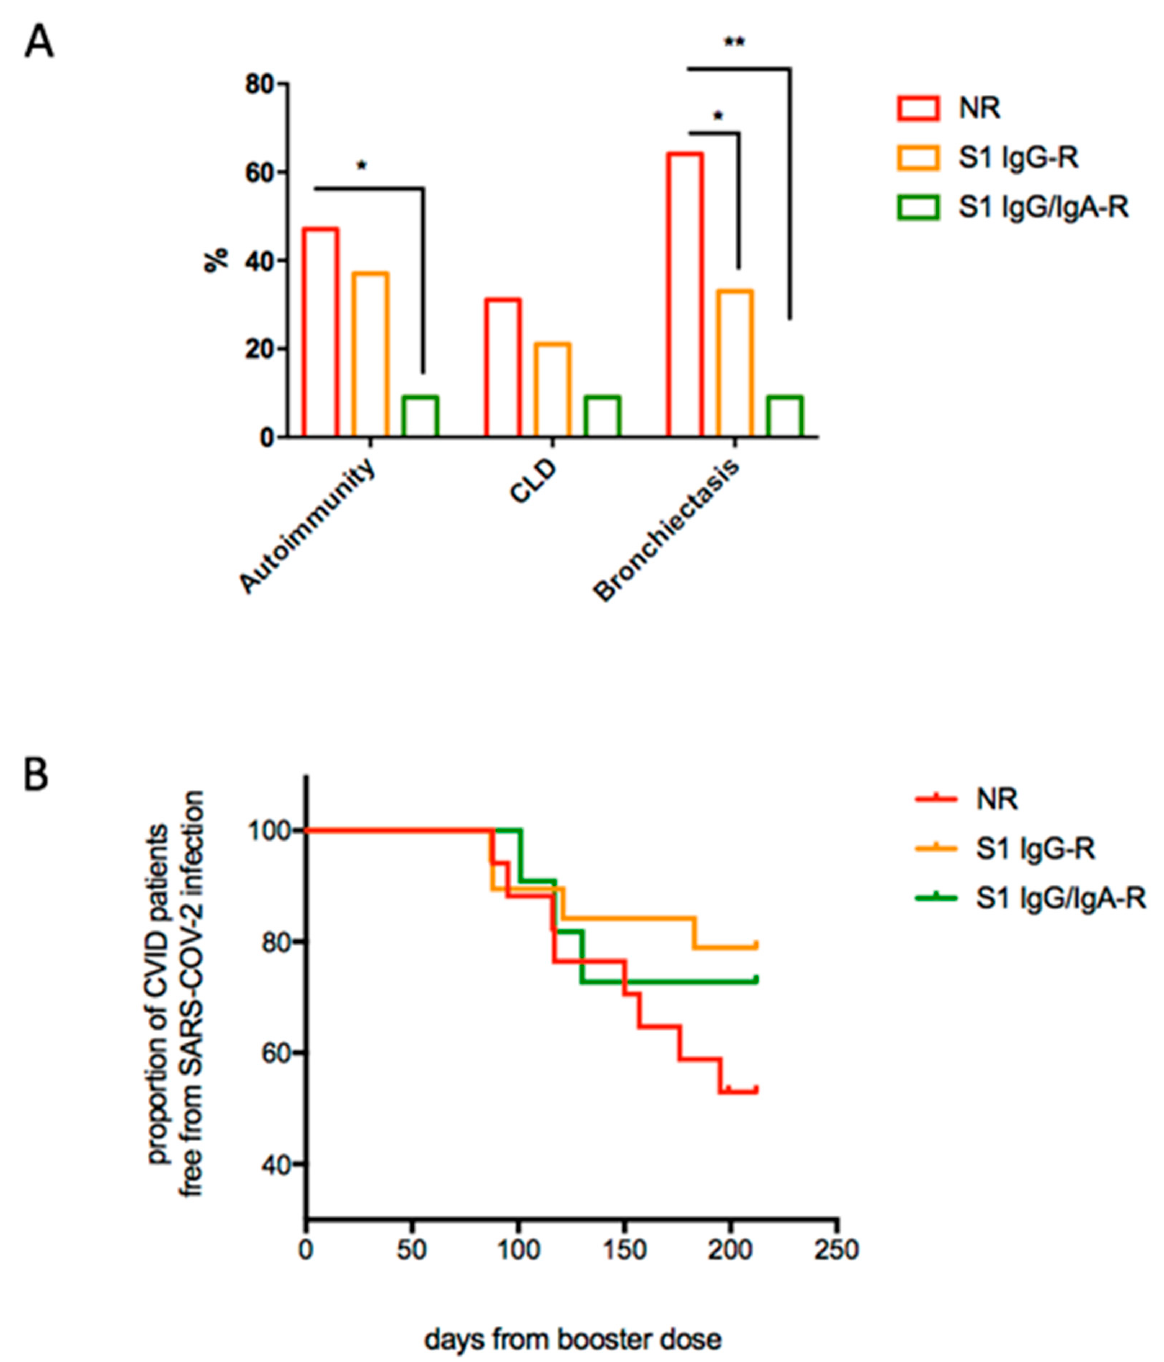
Figure 2. CVID-associated clinical manifestations ( A ) and proportion of CVID patients free from SARS-CoV-2 infection after the booster dose of the mRNA BNT162b2 vaccine ( B ). ( A ): bars represented frequencies of CVID-related complications. Statistical significance was determined using a two-tailed Chi-square test. ( B ): Time to COVID-infection after the third dose of vaccine administration was assessed by using Kaplan–Meier product-limit estimates and based on a log-rank and Gehan–Breslow–Wilcoxon test (difference among groups not significant). * p < 0.05, ** p < 0.01 (NR n = 17; IgG-R n = 18, IgG/IgA-R n = 12).